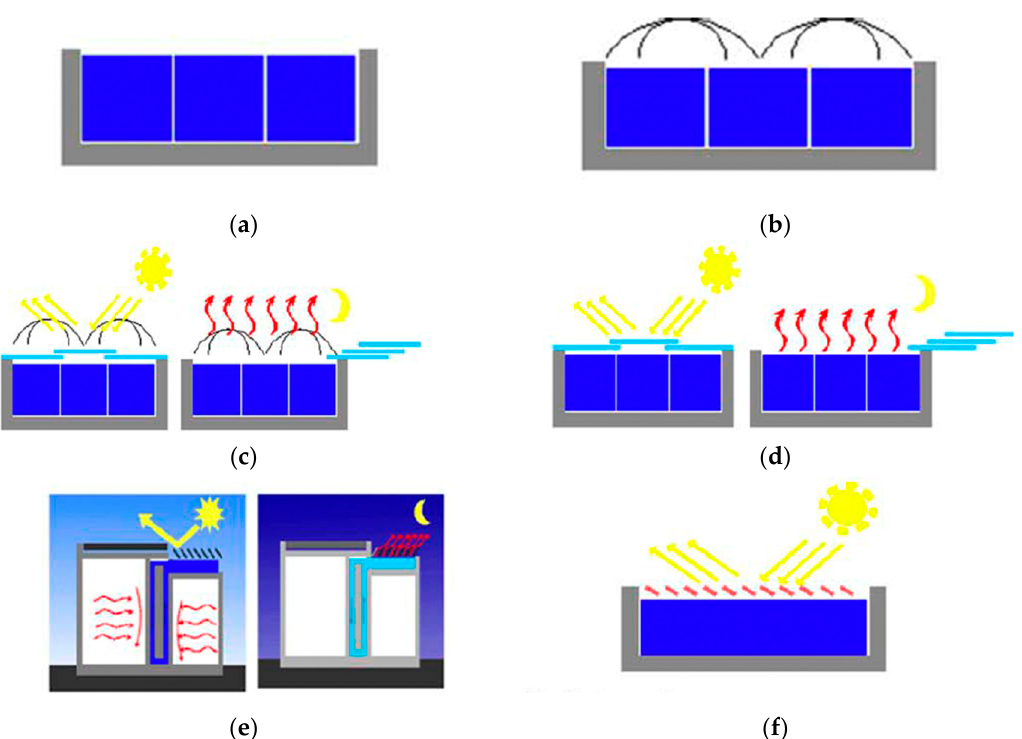
Figure 4. Different roof pond configurations: uncovered ( a ); uncovered with sprays ( b ); covered with sprays ( c ); covered without sprays ( d ); a cool-pool ( e ); and a shaded pond ( f ). Adapted from